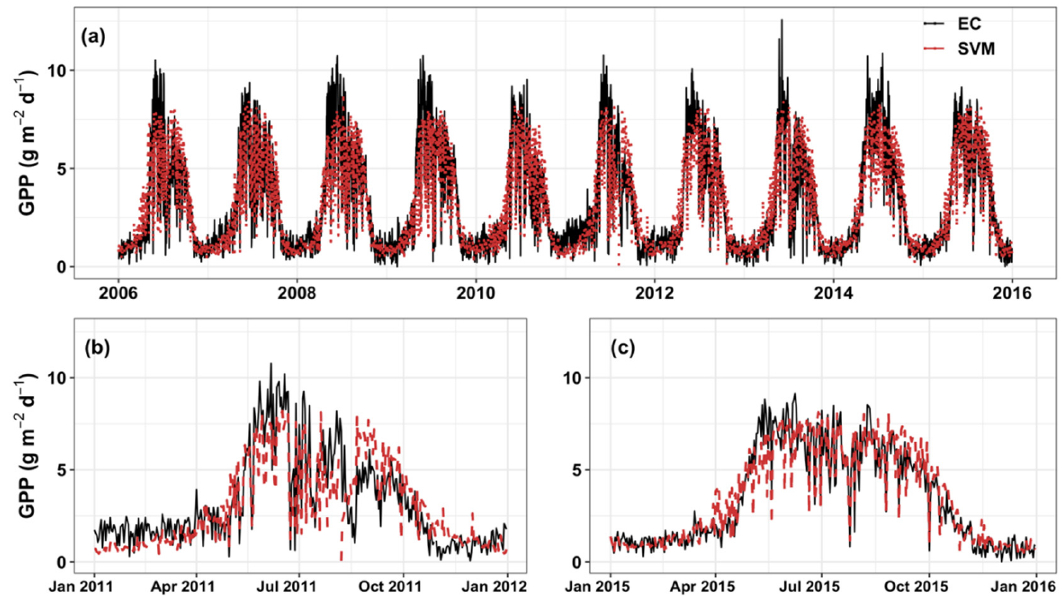
Figure 4. Daily gross primary productivity (GPP) observed by the eddy covariance (EC) method and predicted by a support vector machine (SVM) model at the Gwangneung site during 2006–2015 ( a ), and the predictions zoomed-in for 2011 ( b ) and 2015 ( c ).